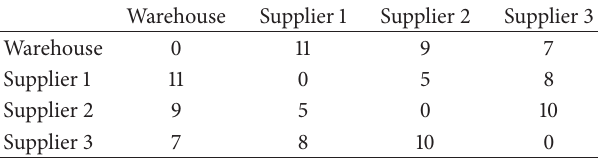
Table 3: The distance between the warehouse and suppliers. Warehouse